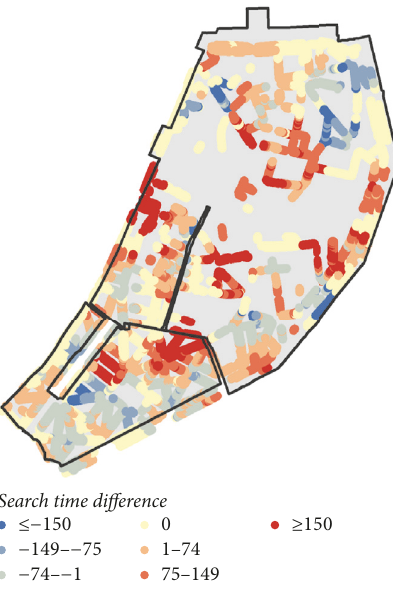
Figure 6: Spatial variation in search time for on-street parking: difference in seconds between regular cars and smart cars, at afternoon peak hours and for a penetration rate of 0.2.